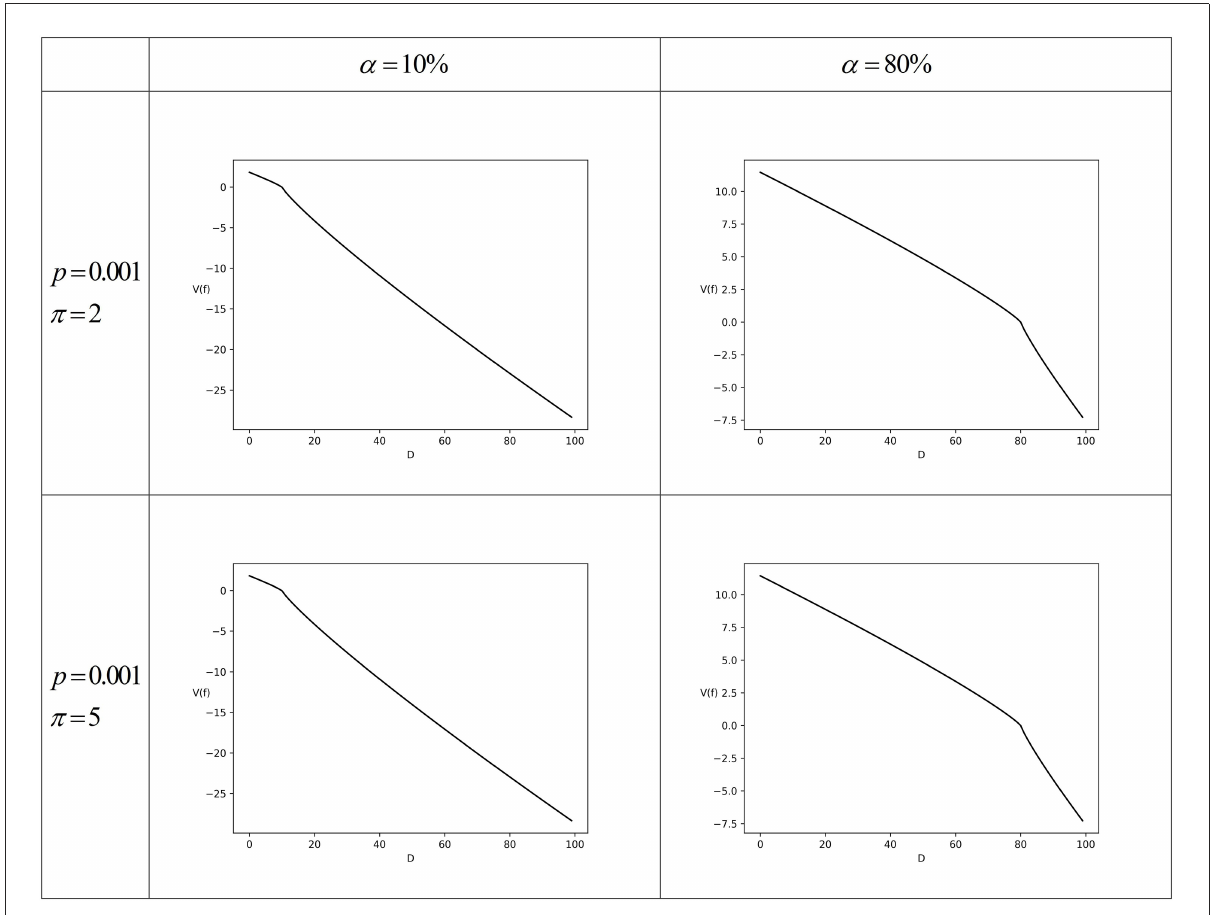
FIGURE1 The numerical simulation for Scenario 1 (complete tax